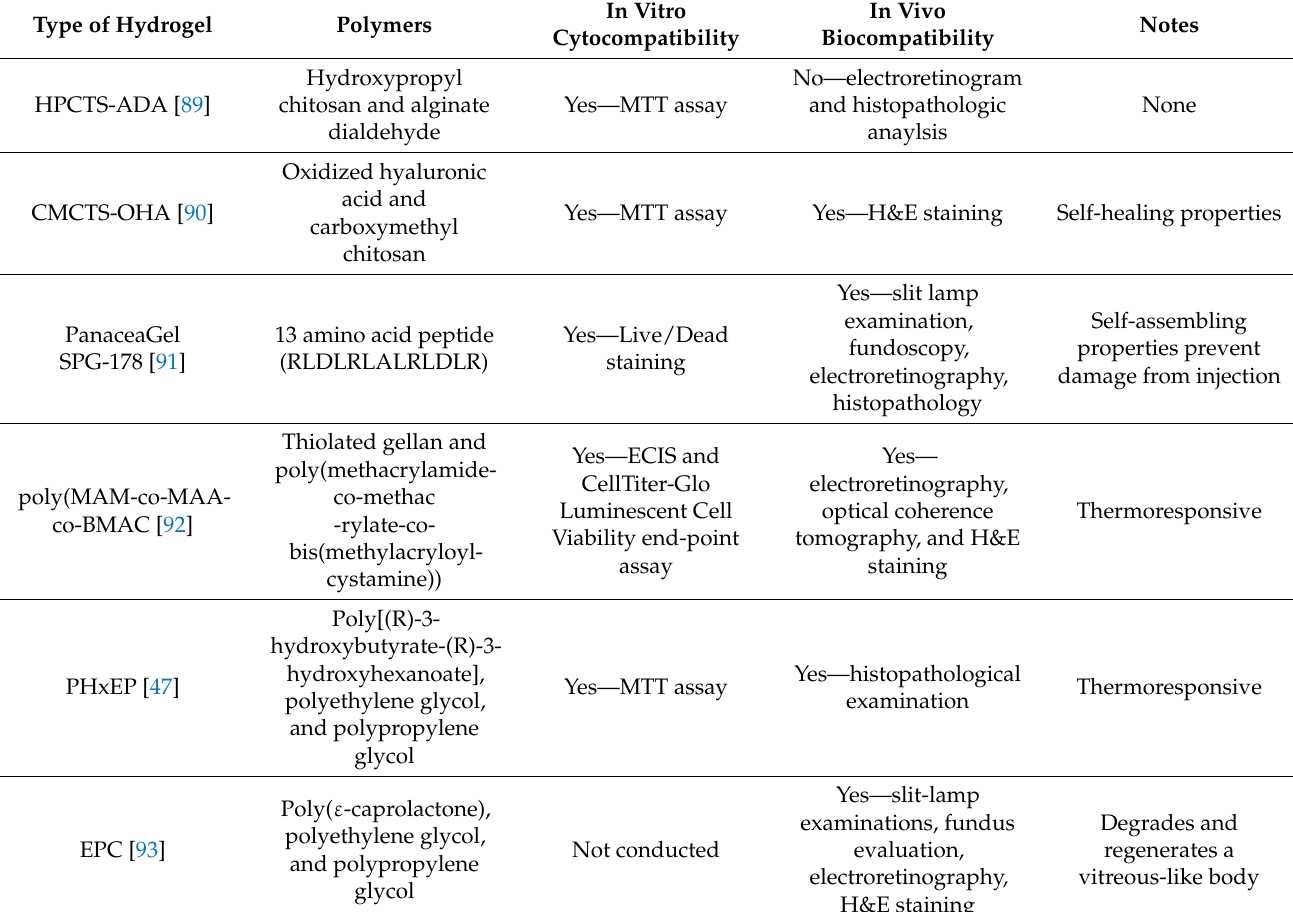
Table 2. Summary of hydrogels investigated as vitreous